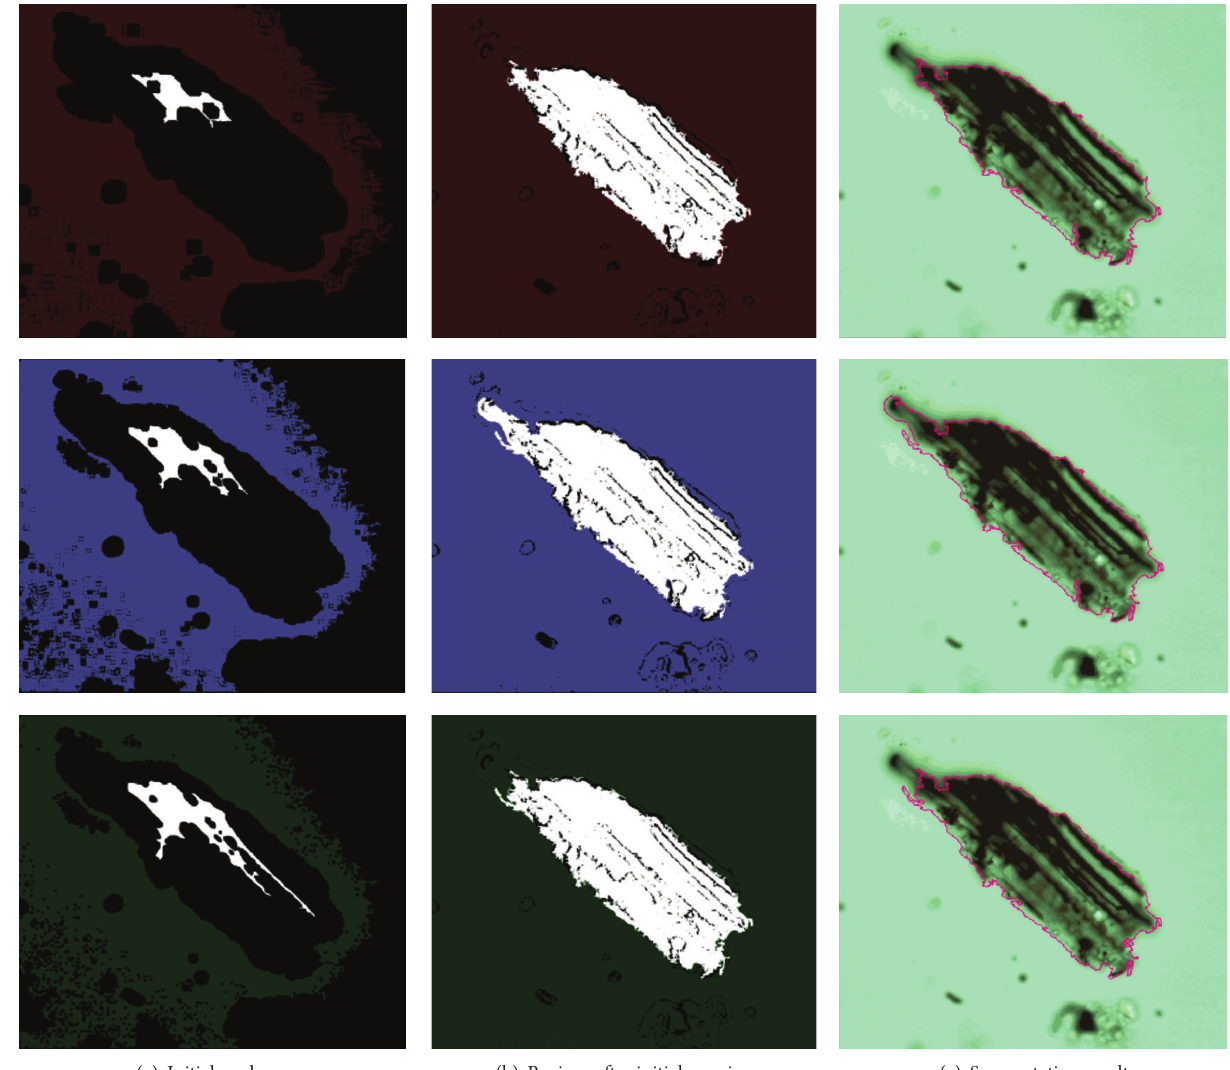
Figure 7: An example of final segmentation results under 3